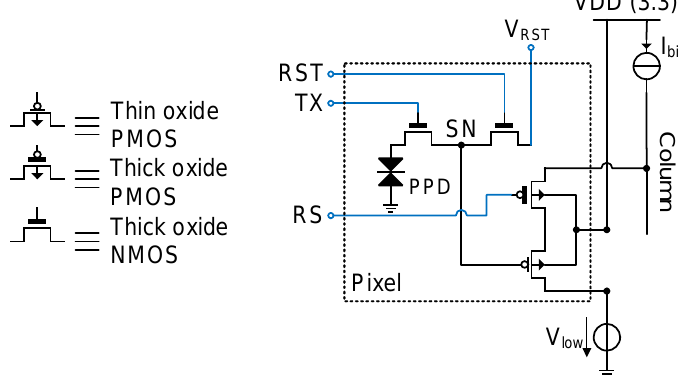
Figure 12. Schematic of the recently-proposed pixel [8] based on a thin oxide PMOS source